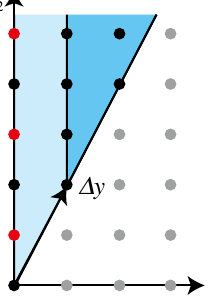
FIG. 8. The shift vector Δ y in SG 199. Points in represented by the black dots, the polyhedral cone X is shaded light blue, the shifted polyhedral cone Δ y þ X is shaded blue, and ¯ X points in Z 2 ∩ X − are represented by red dots. All the points ¯ X are in X − ð Δ y þ X Þ and are close to the boundary in Z 2 ∩ X − of X